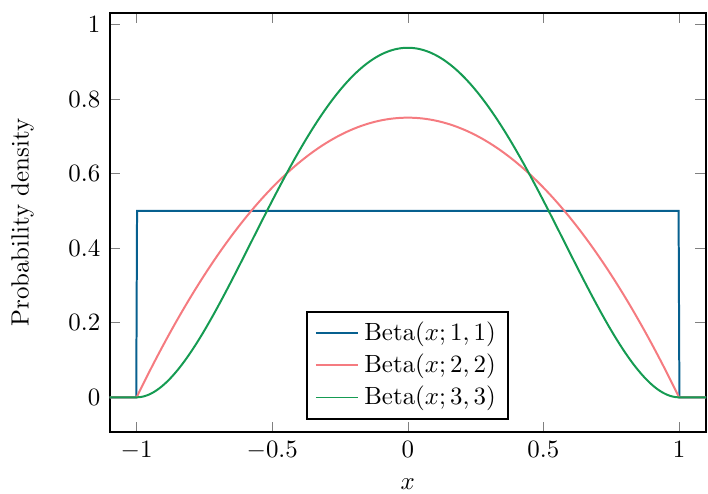
Figure 9. The three different Beta distributions used in this work.